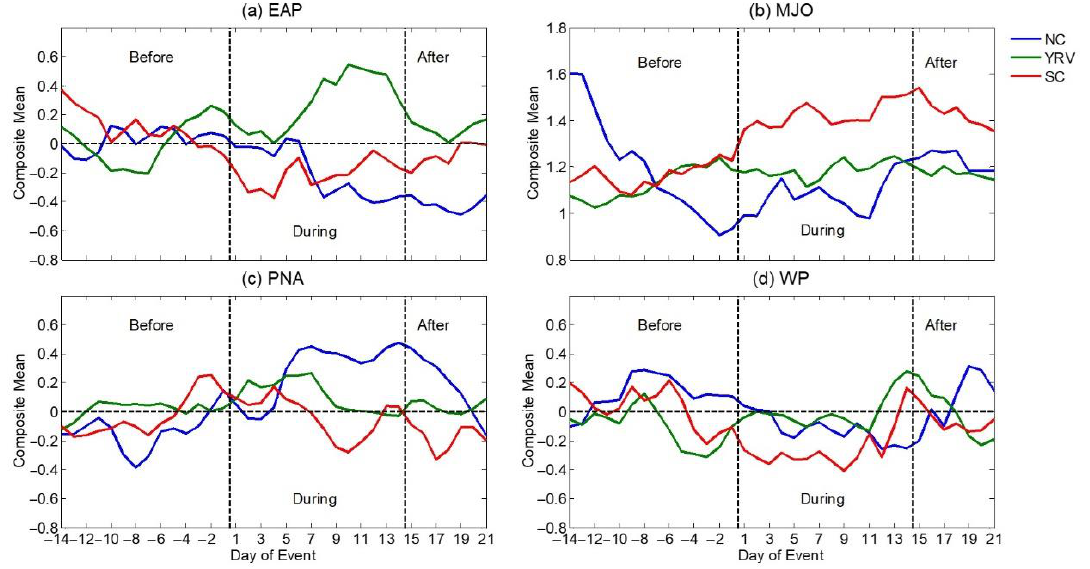
Figure 9. Lag composite time series for the atmospheric teleconnection Patterns (standardized) be- fore, during, and after 14-day PEPEs. ( a ) East Asia-Pacific pattern (EAP), ( b ) Madden–Julian Oscil- lation (MJO), ( c ) Pacific-North America (PNA), and ( d ) Western Pacific